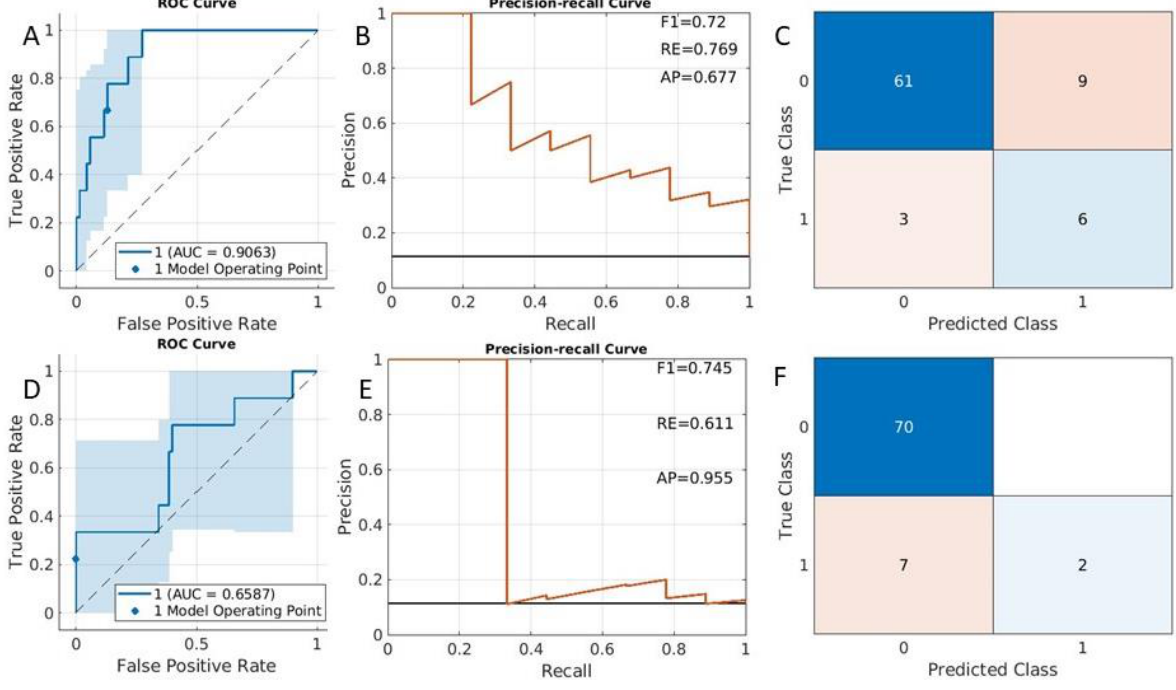
Figure 5. Cancer histological type classification results from testing datasets. ( A , D ) are ROC curves; ( B , E ) are precision – recall curves; ( C , F ) are confusion matrices. ( A – C ) were obtained from an ensemble classification method, while ( D – F ) were obtained from the LASSO method.